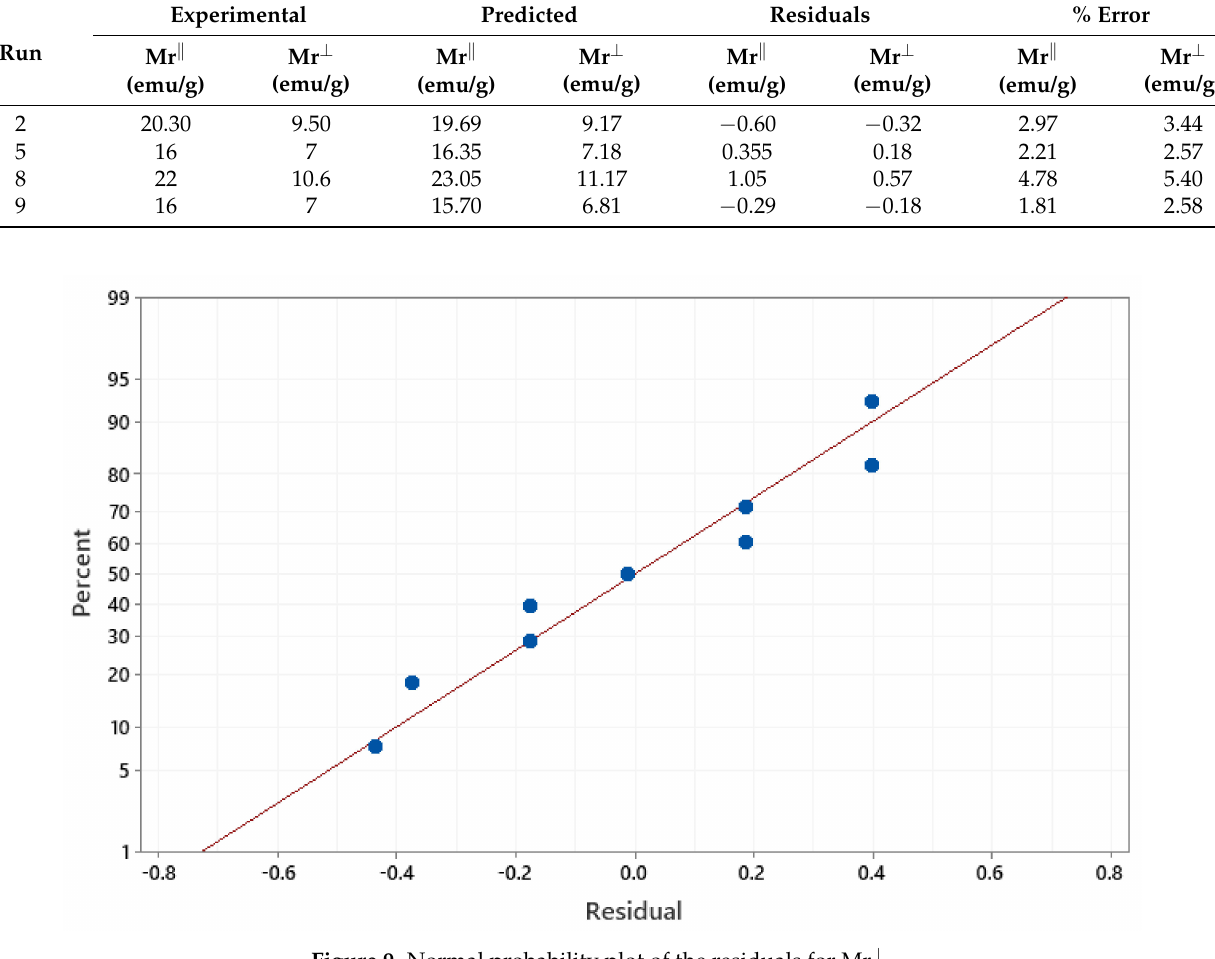
Figure 9. Normal probability plot of the residuals for Mr ⊥